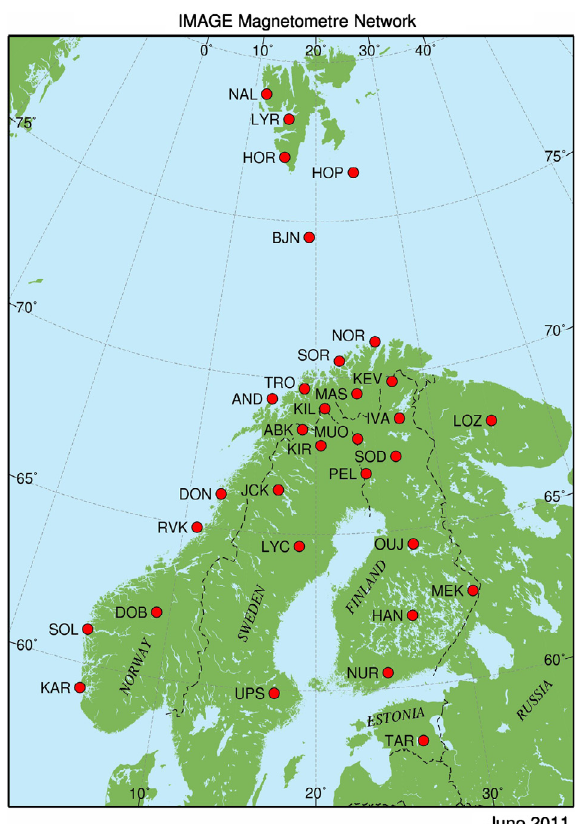
Fig. 1. IMAGE magnetometre network in northern Europe in 2011.